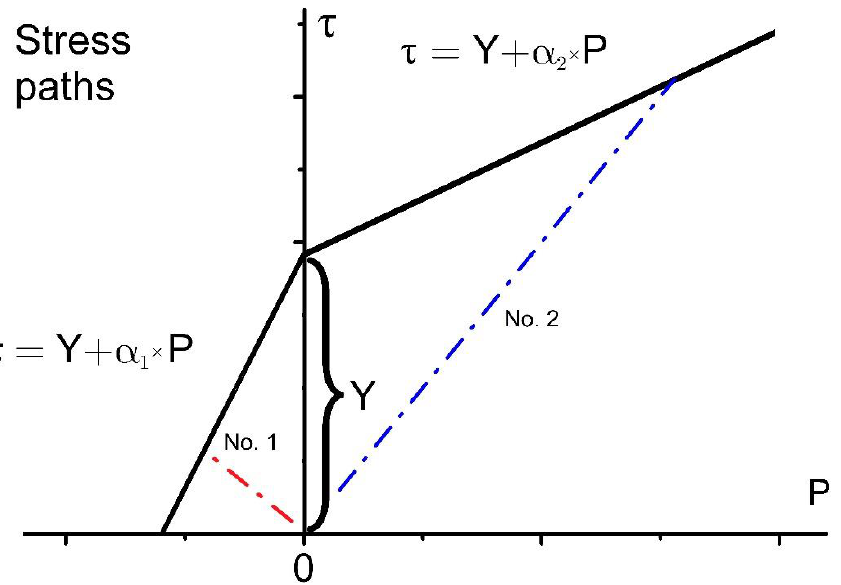
Figure A1. Schematic representation of the double-slope yield surface and possible loading paths of a single continuum point. A continuum point is assumed to be fractured when the damage parameter D reaches unity. After fracture, the continuum point no longer resists tensile stresses (all stress tensor components are nullified when hydrostatic pressure P is negative) but still resists shear and compressive stresses with a local strength of τ = α P (when hydrostatic pressure P is positive).